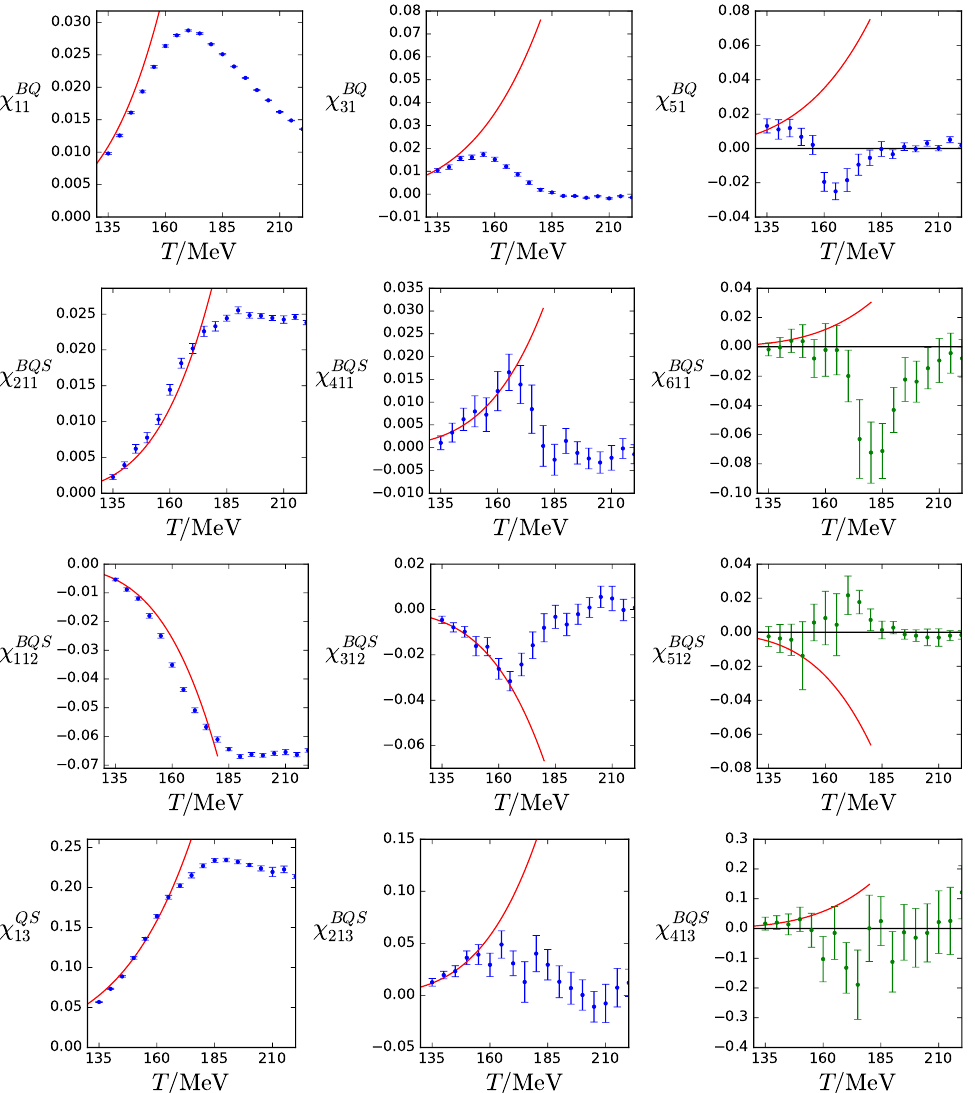
Figure 11 . Results containing one electric charge derivative on the various correlators on our 48 3 (cid:2) 12 lattice as functions of the temperature. Green data points denote our estimates for the high orders, these were (cid:12)tted using a prior distribution. The red curves are the HRG model results. staggered fermions [28]. Correlators that are not protected by a baryon derivative are a(cid:11)ected by signi(cid:12)cant discretization errors. It is understood in the HRG model context that discretization errors mostly a(cid:11)ect the contributions from pions and kaons. Staggered lattice e(cid:11)ects introduce the highest relative errors for the lightest mesons. Luckily, how- ever, quantities with such discretization e(cid:11)ects come with a small pre-factor into the (cid:12)nal formulas of eqs._ (4.4){(4.6). If we had a complete isospin symmetry (factor 0.5 between h n i and h n i in eq. (4.1)) then electric charge correlators would play no role at all in the Q B extrapolation of baryon